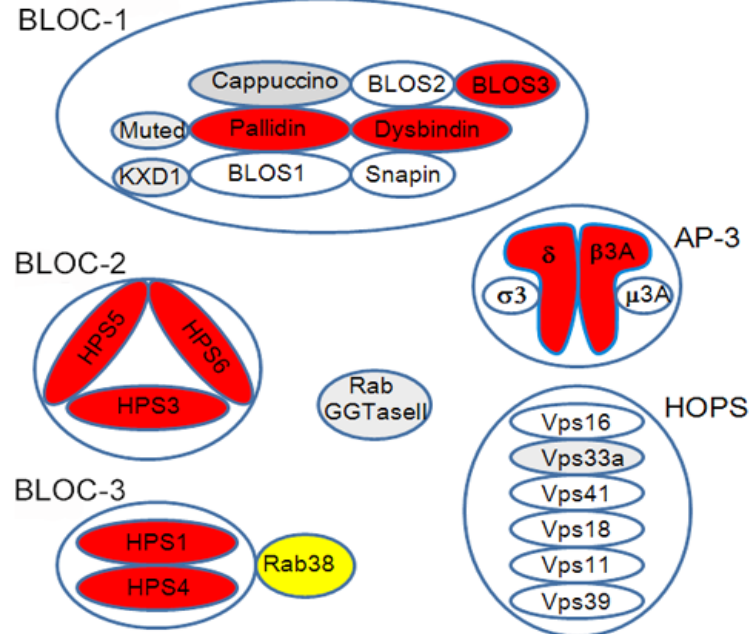
Figure 2. HPS protein complex. Red-colored molecules were identified in both mouse and human HPS, while gray-colored molecules were identified only in mice. Yellow-colored Rab38 is recognized as an HPS molecule in rats, but not completely in mice. BLOC3 functions as a guanine nucleotide exchange factor (GEF) for Rab38 [37].